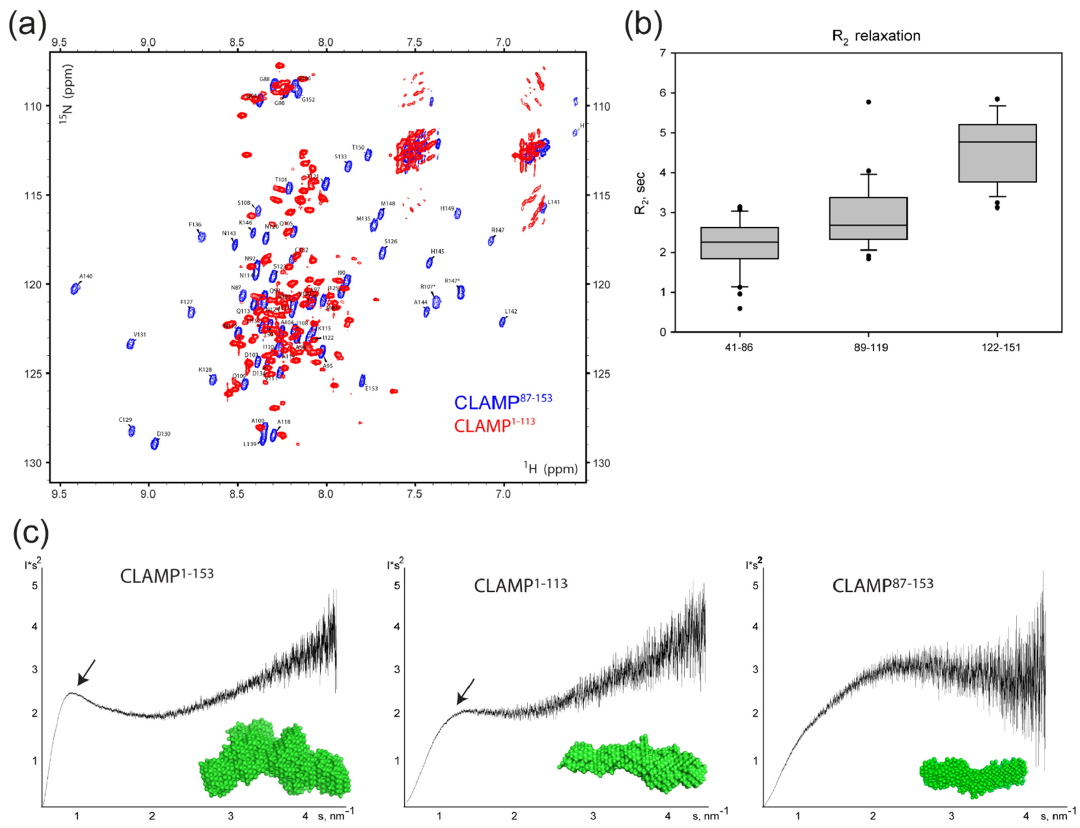
Figure 3. ( a ) 15 N- 1 H-HSQC spectra of D. melanogaster CLAMP 1–113 (red) and CLAMP 87–153 (blue).